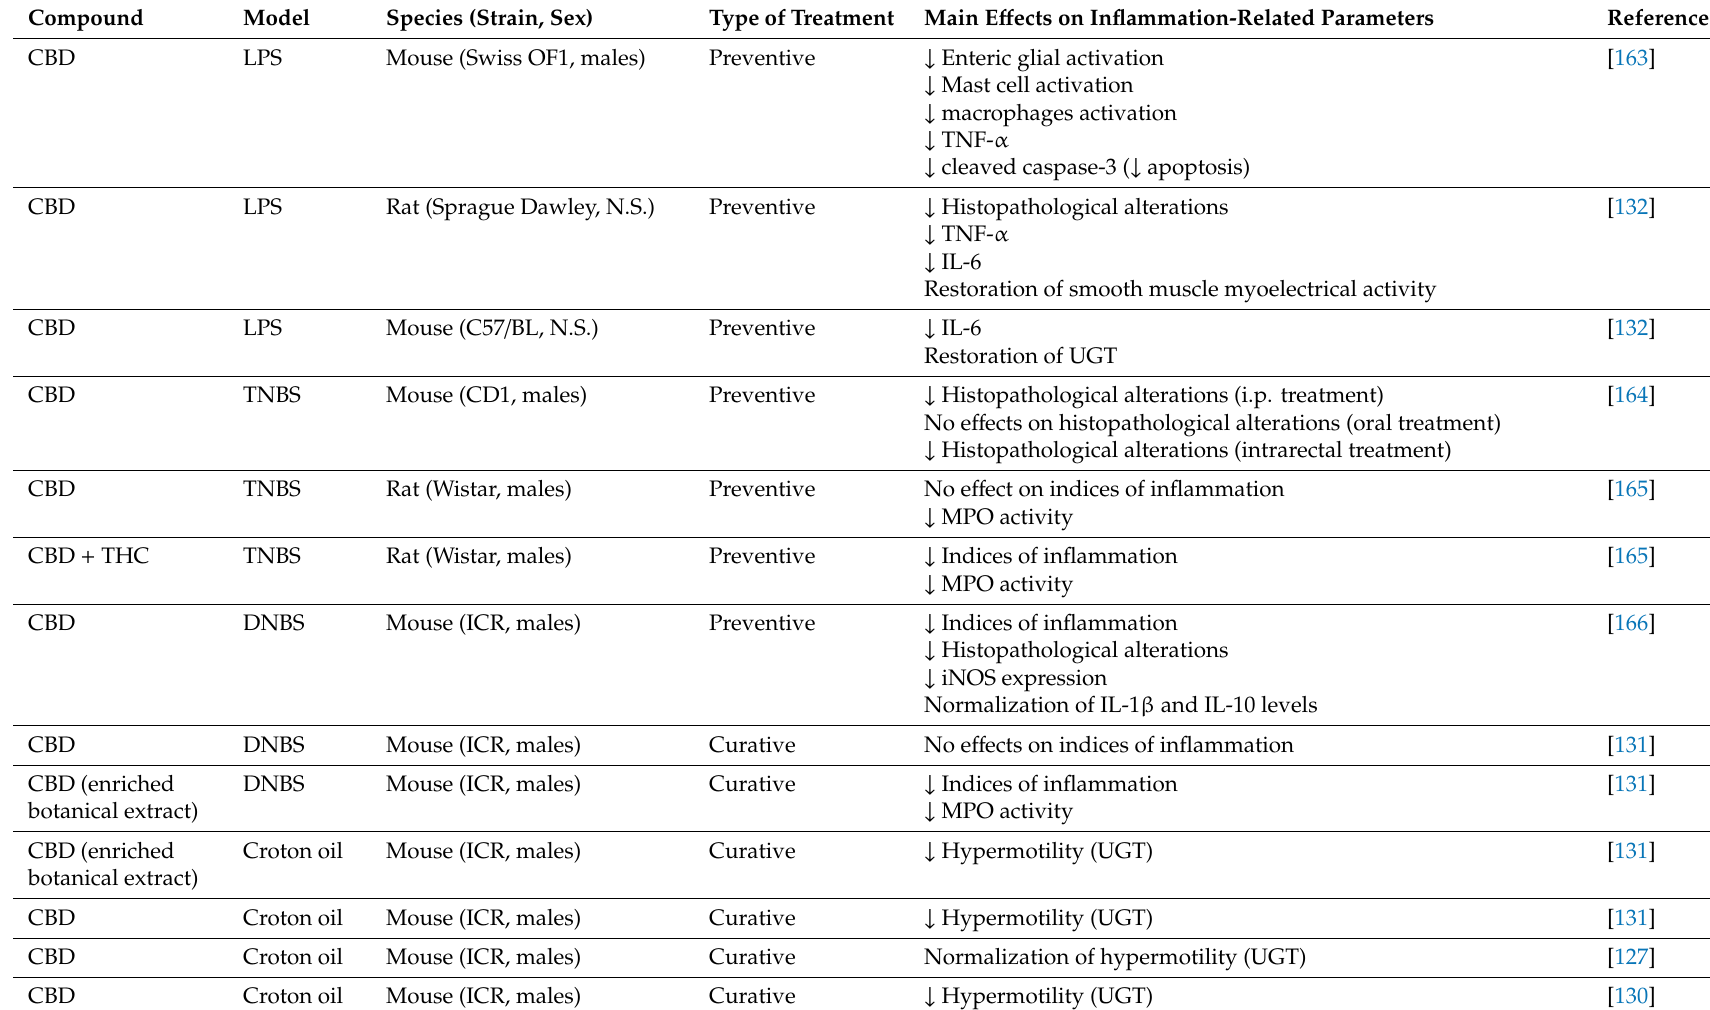
Table 4. Anti-inflammatory activity of non-psychoactive phytocannabinoids in animal models of intestinal